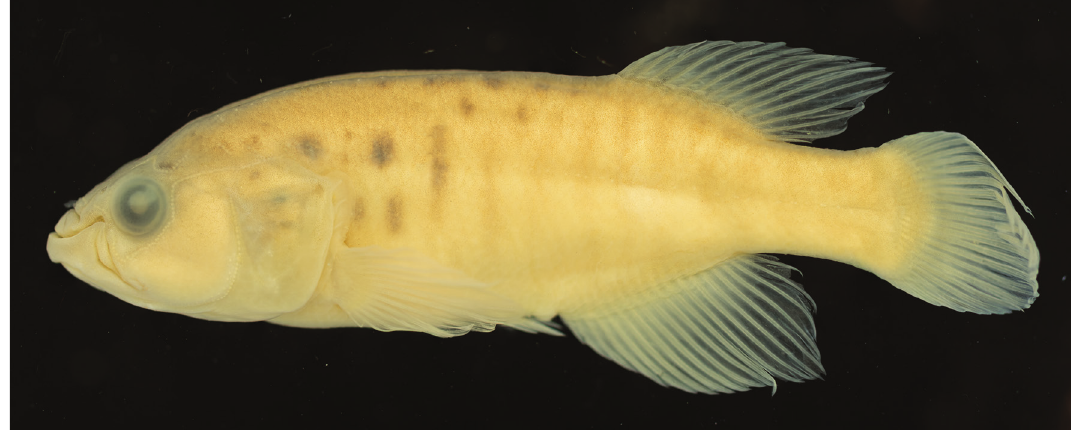
Figure 4. Cynolebias gorutuba sp. n., preserved paratype, UFRJ 9447, female, 50.1 mm SL. Photograph by A. Katz.